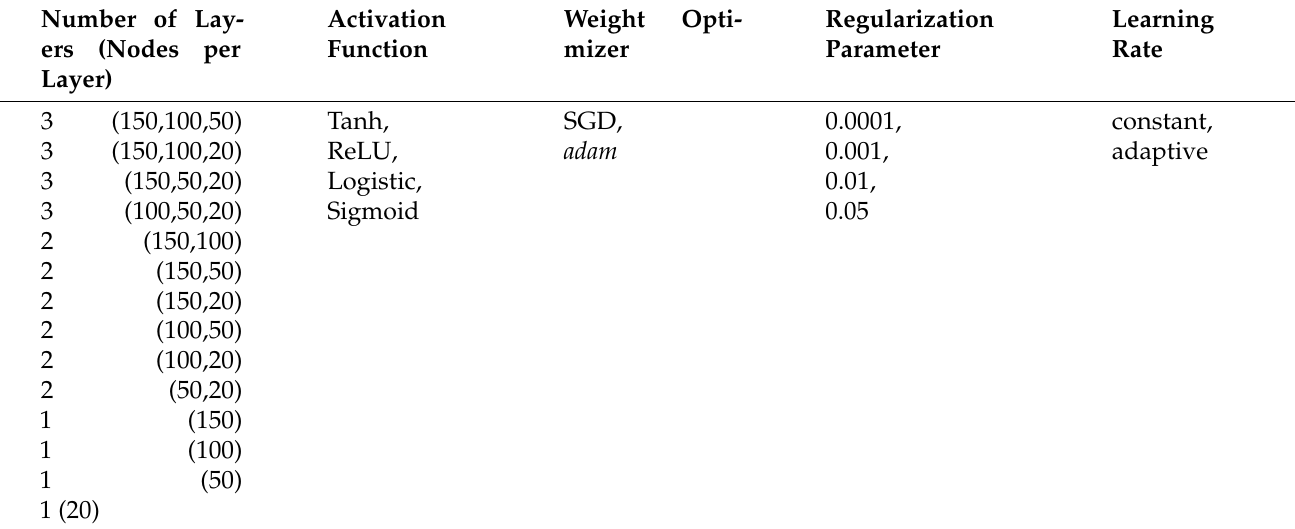
Table 4. The different DNN architectures explored by Grid